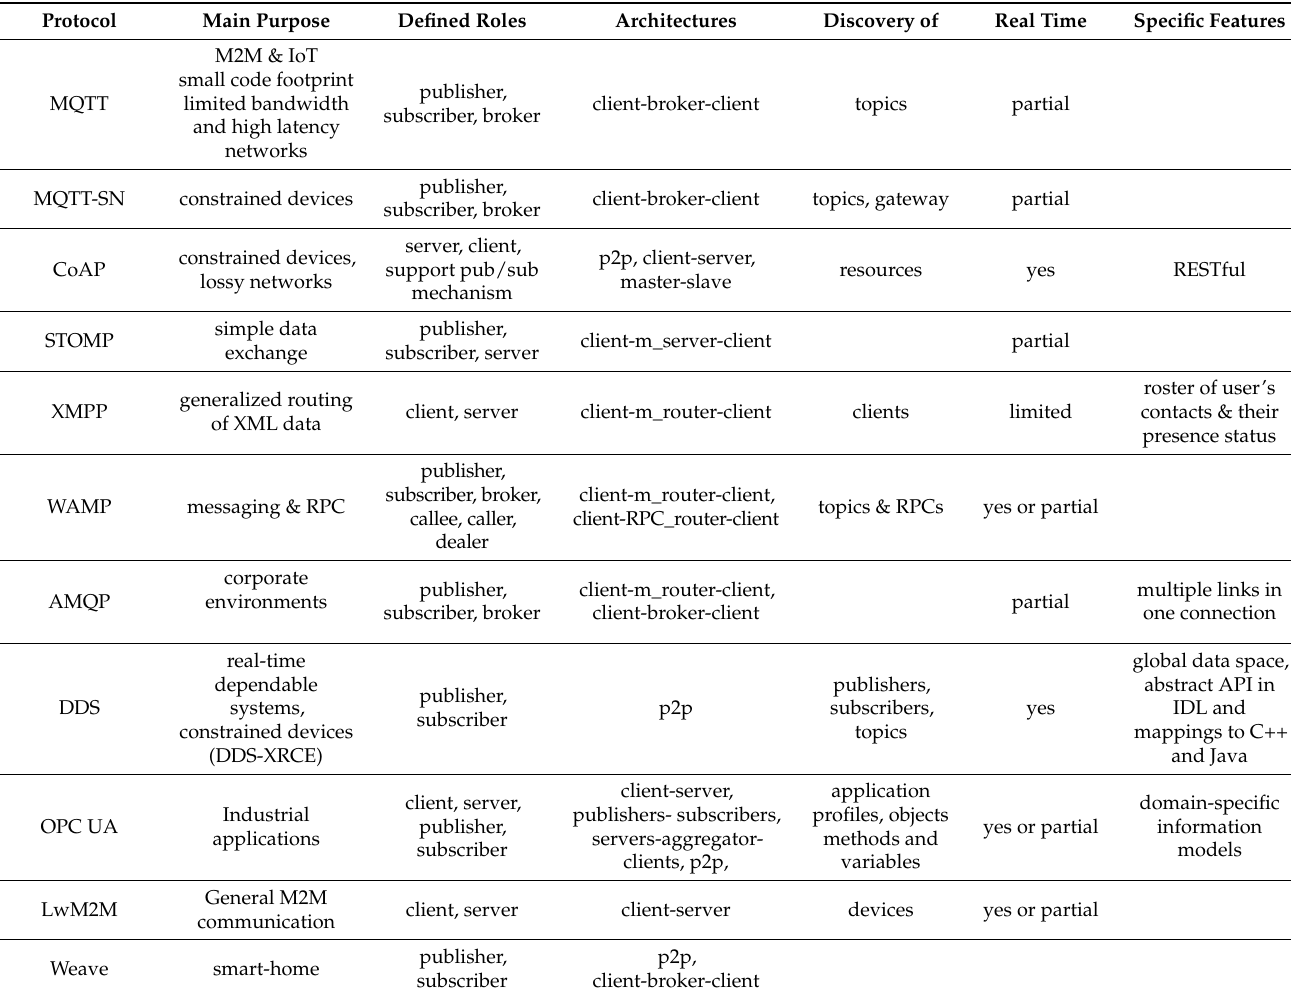
Table 1. Protocol objectives and related